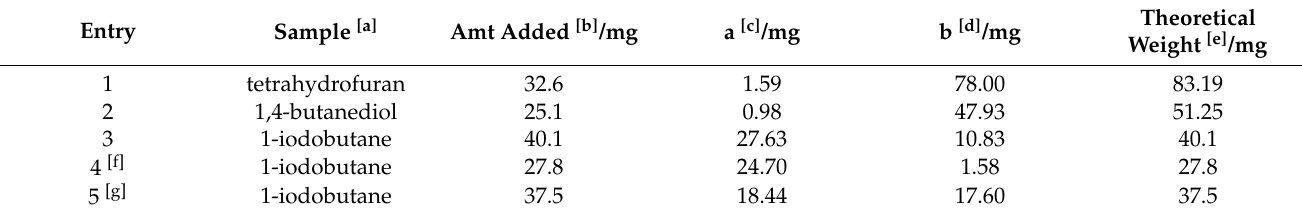
Table 1. Control experiments.